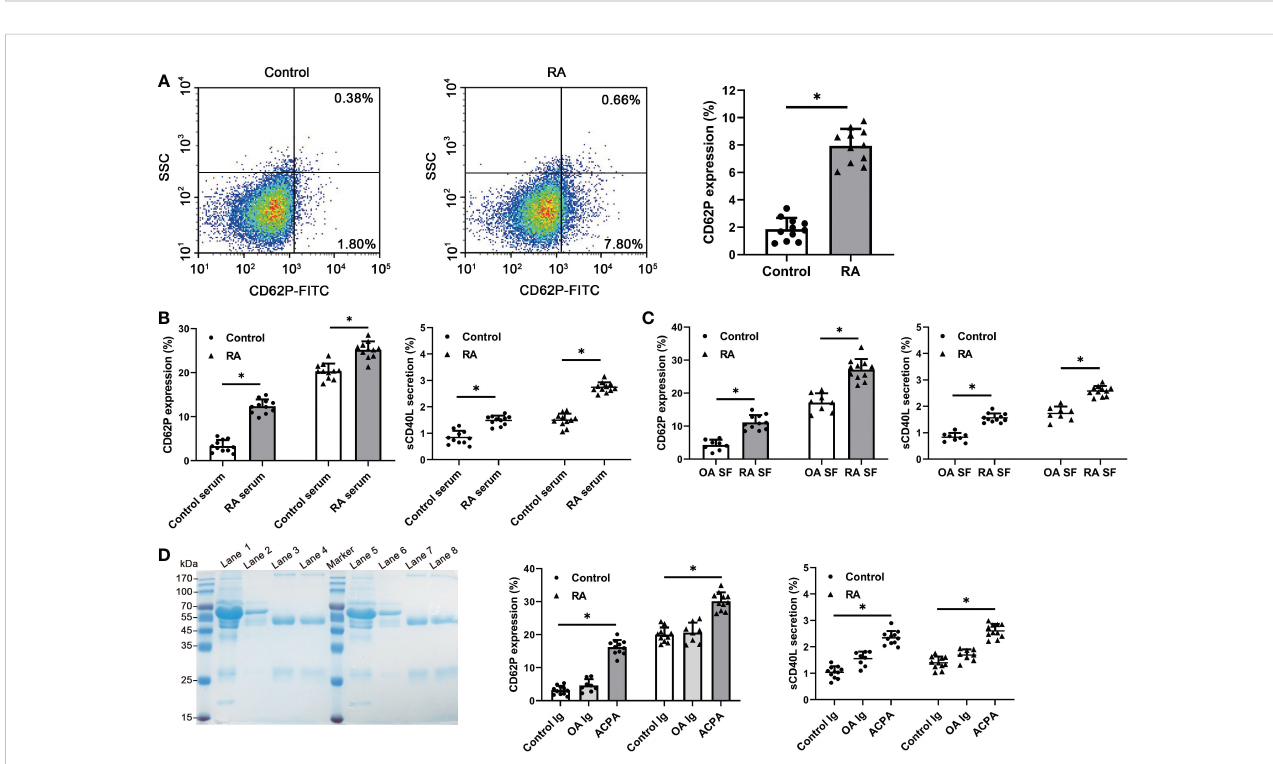
FIGURE 4 Detection of platelet activation after RA serum, SF or puri fi ed ACPA stimulation. (A) Flow cytometric quanti fi cation of CD62P expression in the platelets from healthy controls and RA patients. Data are representative of six independent experiments. (B, C) Both the serum and SF from RA induced signi fi cantly a higher level of CD62P expression and sCD40L secretion in RA and healthy platelets, compared to the healthy serum or OA SF (RA serum and SF: n=11, healthy control serum: n=11, OA SF: n=8). (D) Puri fi ed ACPA from RA SF and serum samples has signi fi cantly enhanced the CD62P expression and sCD40L secretion in RA and healthy platelets. SDS-PAGE showing the puri fi ed ACPA from SF of 2 RA patients by protein G plus beads and CCP2-peptide coated resin. Lane1/lane5: SF; Lane2/lane6: fl ow through from protein G column; Lane3/lane7: eluted IgG from protein G column; Lane4/lane8: eluted ACPA from CCP2-coated resin. Data are presented as mean ± SD, *p <